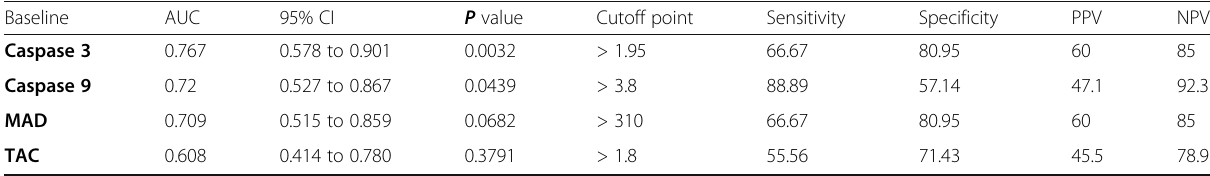
Table 2 Comparison between caspase 3, caspase 9, MAD, and TAC in mortality prediction for OP poisoning cases